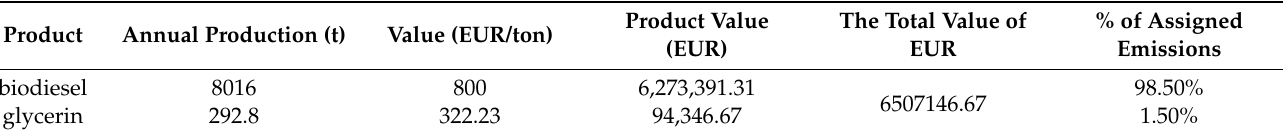
Table 13. Allocation of emissions taking into account the market value of the resulting products.